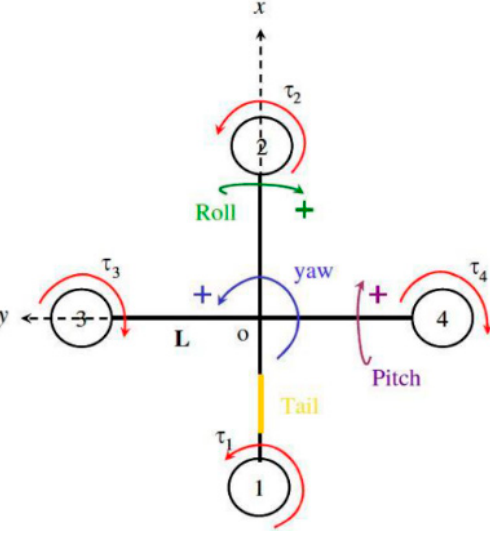
Figure 1. Schematic representation of a quadrocopter.